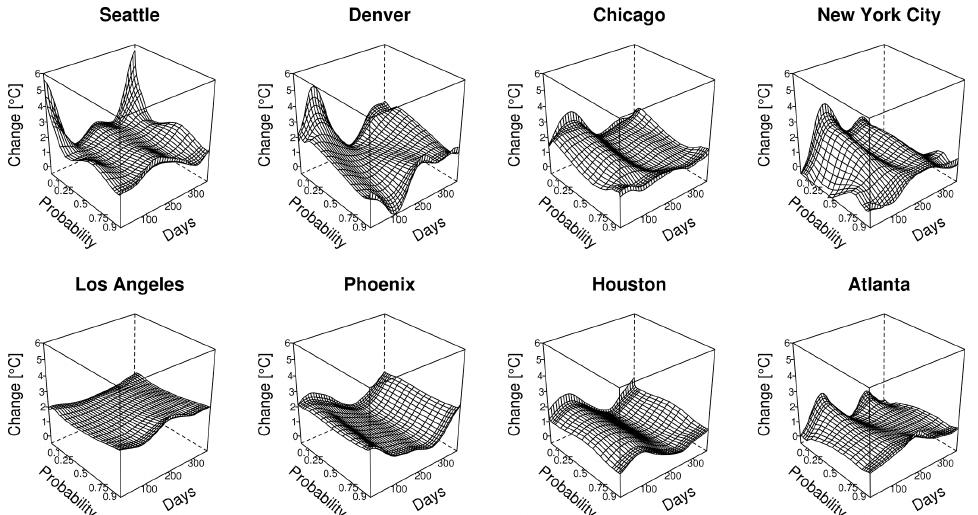
Figure 6. A double quantile map calculated for eight locations, first applying the map estimated from the LENS ensemble from year 1990 to 2090 followed by the inverse map estimated from the SFK15 ensemble from 2090 to 1990. Each map shows only the difference between the mapping and the original temperature. Positive values indicate that the LENS ensemble will transform to warmer temperatures in the future than SFK15 does. If the LENS and the SFK15 quantile maps were the same, these changes would be identically zero.